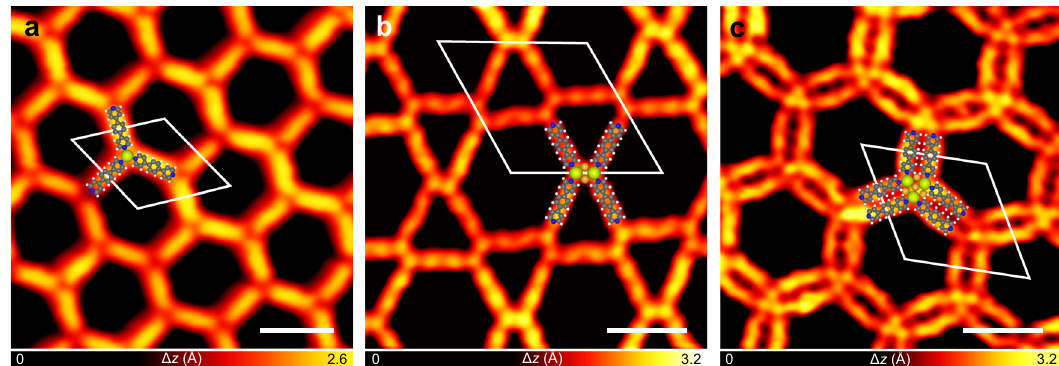
Fig. 2 Coordination structures involving Ce and 1 formed on Au(111). STM images of a the single-wall honeycomb structure (scanning conditions: bias V = − 10 mV, tunneling current I = − 30 pA, imaging temperature T = 77 K), b the Kagome structure ( V = 5 mV, I = 50 pA, T = 77 K), and c the double- wall honeycomb structure ( V = 30 mV, I = 100 pA, T = 77 K) formed by depositing 1 and Ce on Au(111). The structural motifs constructing the coordination structures are illustrated by the superimposed molecular models. Color code: dark gray for C, white for H, blue for N, light green for Ce, and orange for Au adatom. The unit cells are highlighted by the white parallelograms. Scale bars: 2 nm.